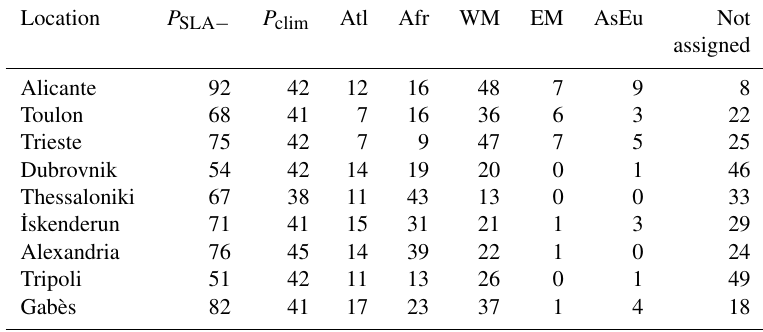
Table 3. Same as Table 2 except it refers to negative sea level anomalies. Location P SLA − P clim Atl Afr WM